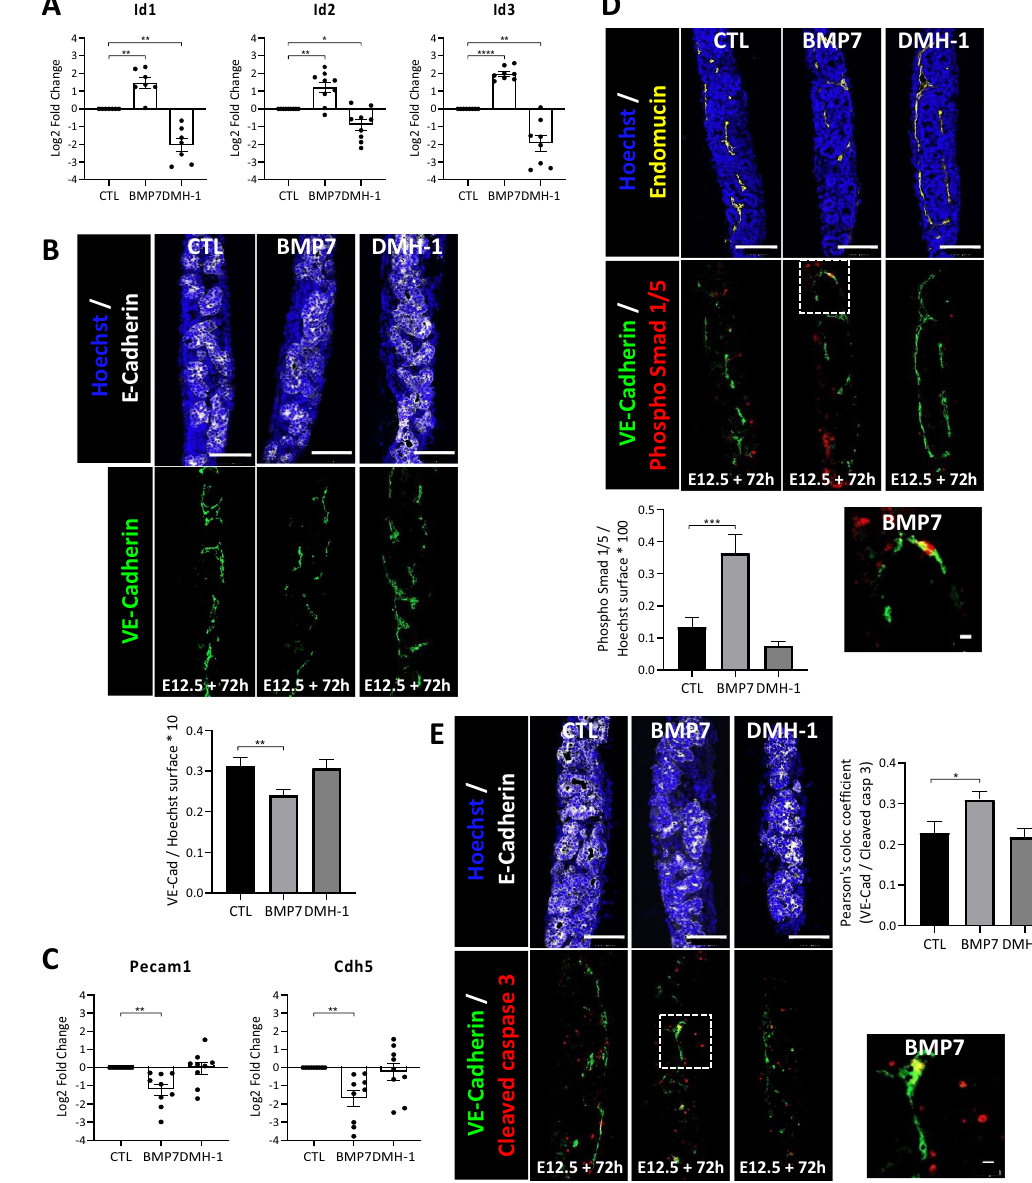
Figure 5. Decreased vascular density, via increased endothelial cell apoptosis, upon BMP7 treatment of pancreatic explants. Pancreatic explants were treated with BMP7 recombinant protein (BMP7, 400 ng/ mL), BMP signalling inhibitor DMH-1 (3 µM), or left untreated (CTL), for 48 h ( A , C ) or 72 h ( B , D , E ). ( A ) RT-qPCR analysis of BMP target genes Id1 , Id2 and Id3 normalized to Actb and Rpl27 , and presented in log2 fold change (n = 7–9). Expression of Id genes was increased by BMP7 and decreased by DMH-1. ( B ) Immunolabeling of epithelial E-Cadherin (white) and endothelial VE-Cadherin (green) cells, with Hoechst nuclei counterstaining (blue). Below, quantification of VE-Cadherin-labelled surface reported to total Hoechst + surface (n = 7) showed decreased vascular density with BMP7. Scale bars: 100 μm. ( C ) RT-qPCR analysis of endothelial ( Pecam1 and Cdh5 ) markers normalized to Actb and Rpl27, and presented in log2 fold change (n = 9). Expression of both endothelial markers was decreased by BMP7. ( D ) Immunolabeling of phospho Smad 1/5 (red) and endothelial endomucin (yellow) or VE-Cadherin (green), with Hoechst nuclei counterstaining (blue). At right, quantification of phospho Smad 1/5 + surface reported to total Hoechst + surface (n = 4) showed increased phospho Smad 1/5 + surface in BMP7-treated explants. Region delineated by dashed lines on the BMP7 explant is magnified below, and highlights an endothelial cell with a phospho Smad 1/5 + nucleus. Scale bars: 100 μm and 10 μm (inset). ( E ) Immunolabeling of cleaved caspase 3 (red), epithelial E-Cadherin (white) and endothelial VE-Cadherin (green) cells, with Hoechst nuclei counterstaining (blue). Measure of the Pearson’s correlation coefficient for colocalization between cleaved caspase 3- and VE-Cadherin-pixels (n = 4) showed increased VE-Cadherin/cleaved caspase 3 colocalization in BMP7-treated explants. Region delineated by dashed lines in the BMP7 condition is magnified below, and illustrates endothelial cell apoptosis. Scale bars: 100 μm and 10 μm (inset). One-way ANOVA (comparison to CTL): * p < 0.05, ** p < 0.005, *** p < 0.0005, **** p <